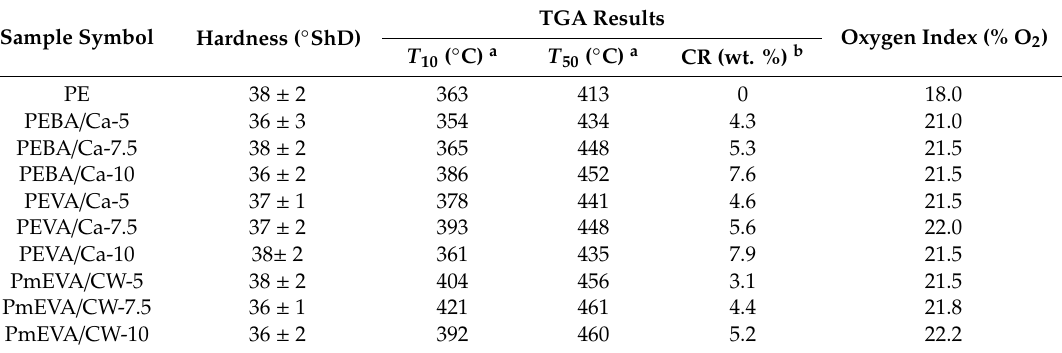
Table 2. Hardness and thermal properties (TGA and limited oxygen index (LOI)) of PE composites with selected MMTs and dispersing